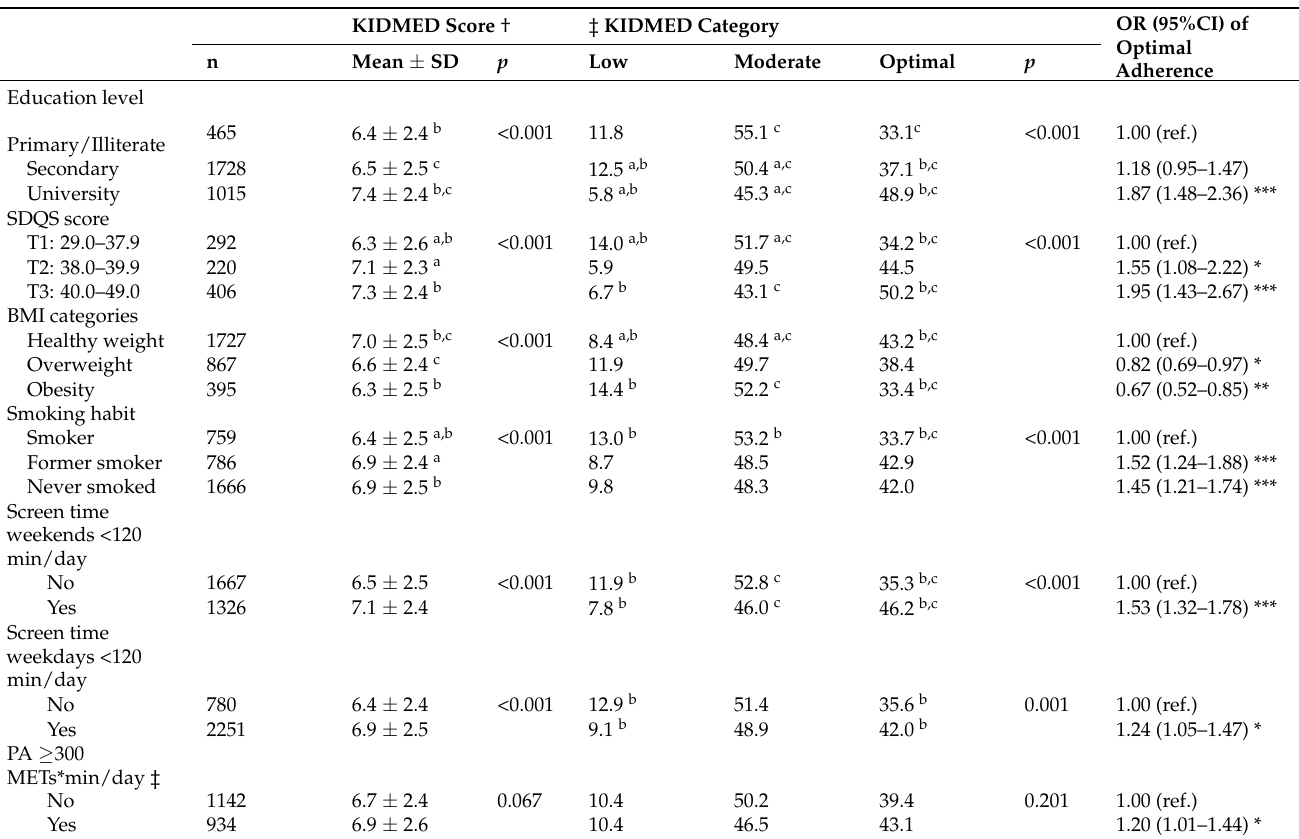
Adherence to the MedDiet of the study population among mother/female legal guardian